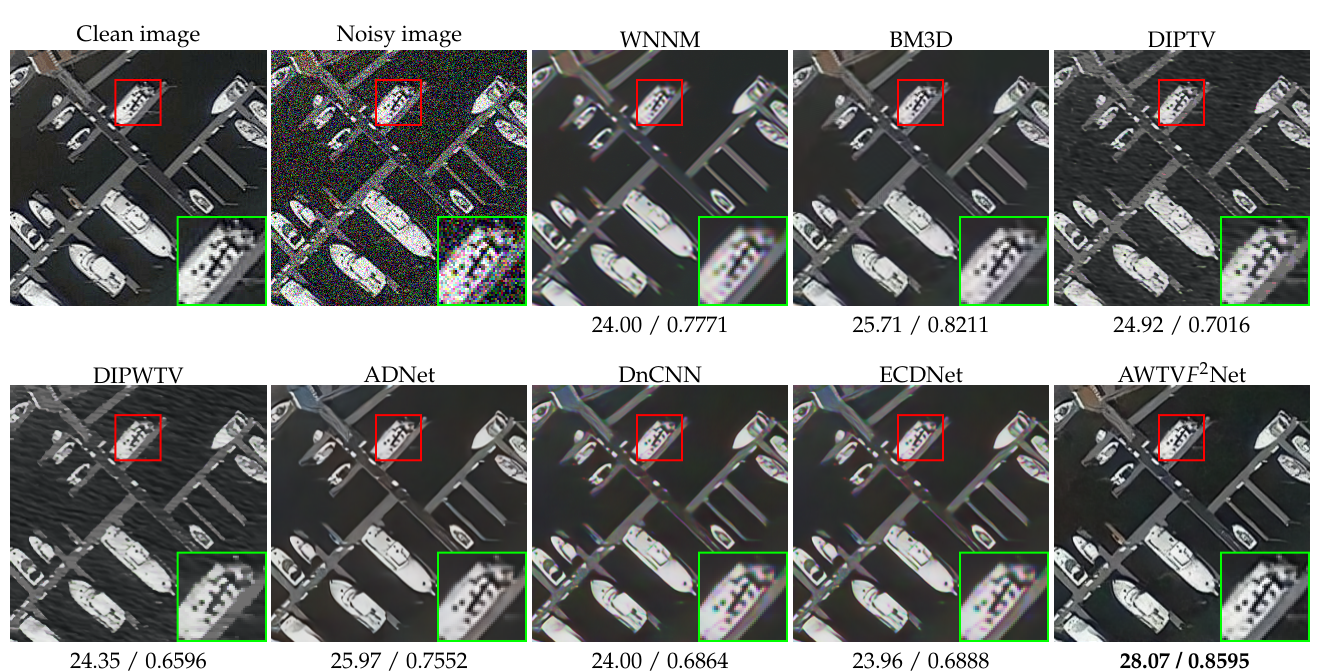
Figure 13. Detailed comparisons on the ‘Harbor’ image with noise level σ =